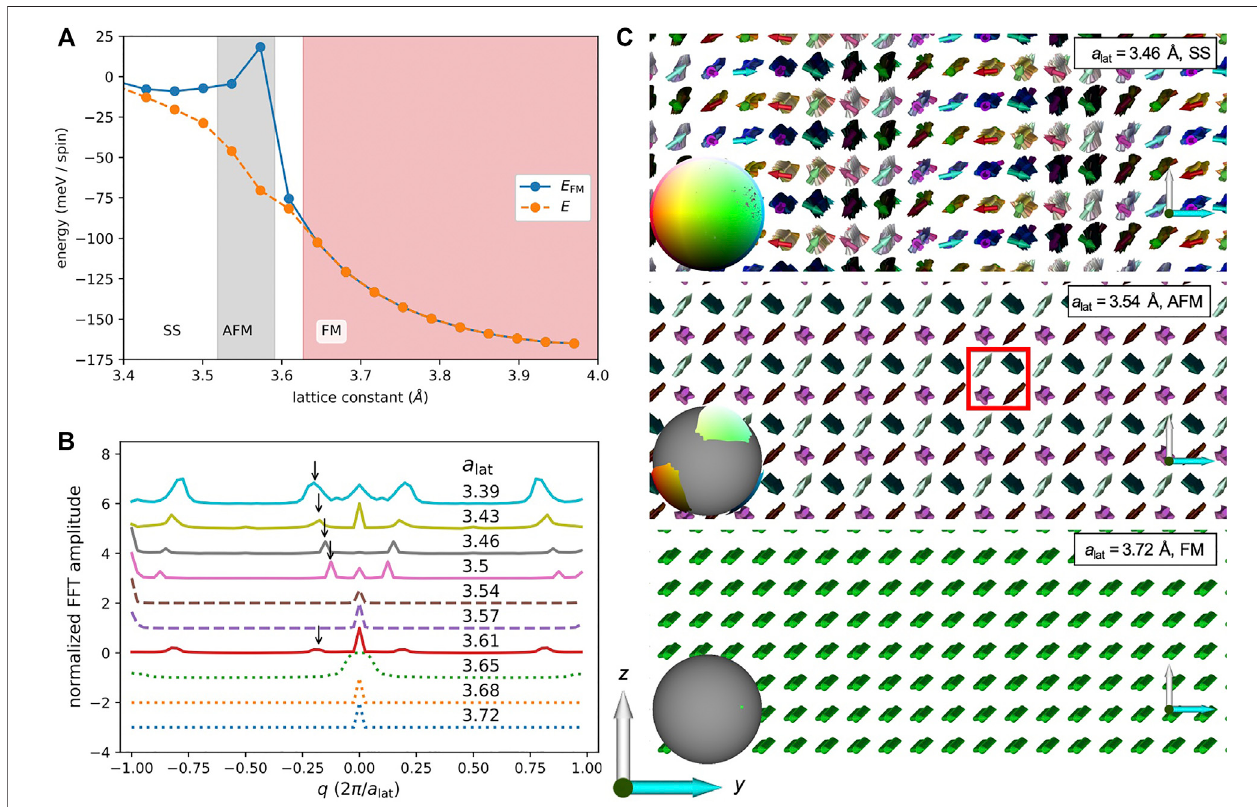
FIGURE7| Magneticgroundstatein γ – Fefromspin-dynamicssimulationsviatheAiiDA-Spiritplugin. (A) Calculatedenergiesperspinofthe fi nalstateafteranLLG calculation. Each data point uses the exchange constants computed from DFT (cf. Figure 5D ). The solid blue and dashed orange lines indicate the energy computed starting from random spin con fi guration or the ferromagentic (FM) state. The white, grey and red shaded areas indicate if, respectively, a spin-spiral (SS), antiferromagnetic (AFM) or FM ordering is found to be the ground state. (B) Normalized Fourier transform of the z -component of the magnetization in the yz -plane fordifferentlattice constants,shiftedforclarity.Solidlinescorrespond toSS,dashed linestoAFM anddottedlines toFMsolutions,respectively. Thearrows highlightthe principalwavenumberofthespin-spiralandhighlighttheirchangewiththelatticeconstant. (C) Visualizationofrepresentativespinstructuresfor(fromtoptobottom) SS, AFM and FM states where the red box in the AFM structure highlights a unit cell with the four sub-lattices. The colored points on the grey sphere in the lower left panels show a projection of the direction of the spins onto the unit sphere.